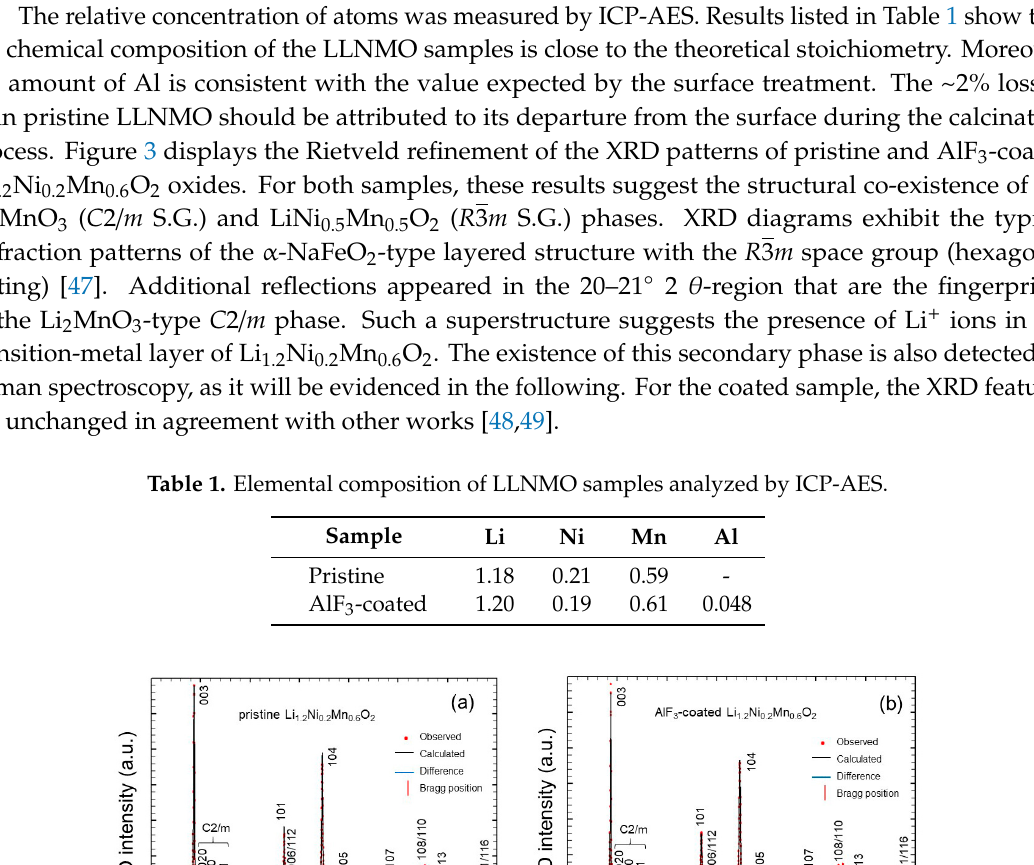
Figure 3. Rietveld refinements for ( a ) pristine and ( b ) AlF 3 -coated Li 1.2 Ni 0.2 Mn 0.6 O 2 Li-rich oxides. XRD patterns were recorded using a CuK 𝛼 source ( λ = 1.5406 Å).